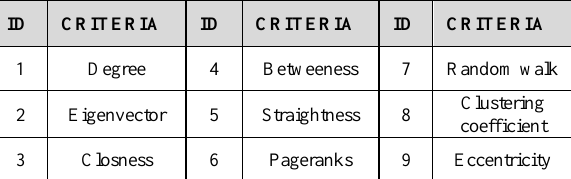
Table 1. The criteria used in this paper